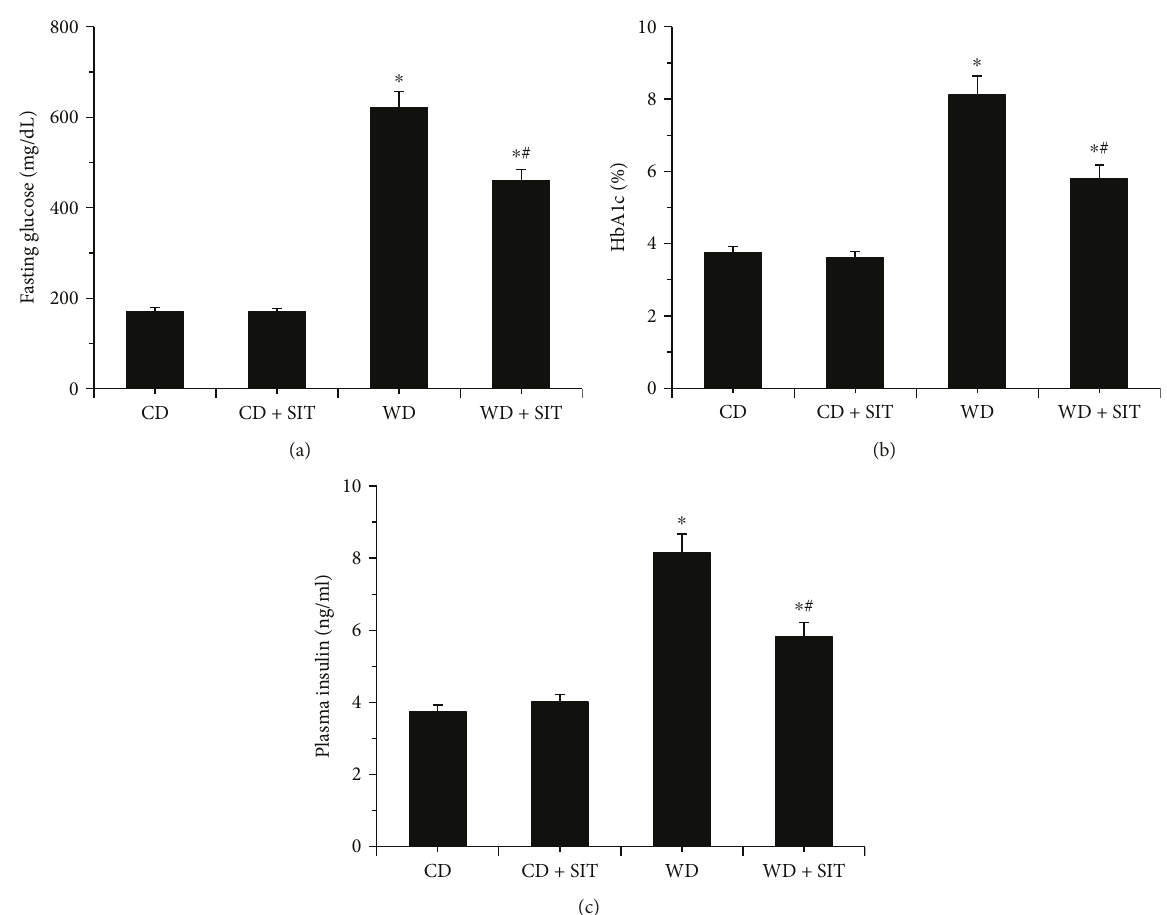
Figure 1: WD mice have elevated fasting glucose and HbA1c levels at the end of treatment. Both fasting glucose (a) and HbA1c (b) were reduced by SIT treatment at the end of the study. WD mice had increased serum insulin concentrations (c). ∗ P < 0 05 compared to CD at the end of experiment; # P < 0 05 compared to WD at the end of